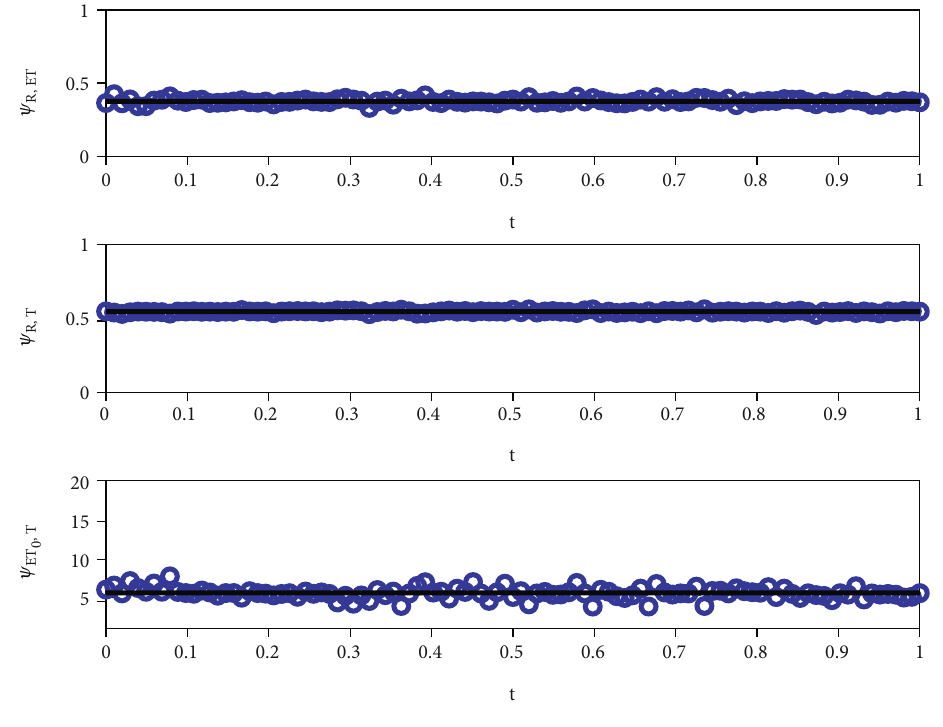
Figure 6: Parametric estimate of ψ ’ s